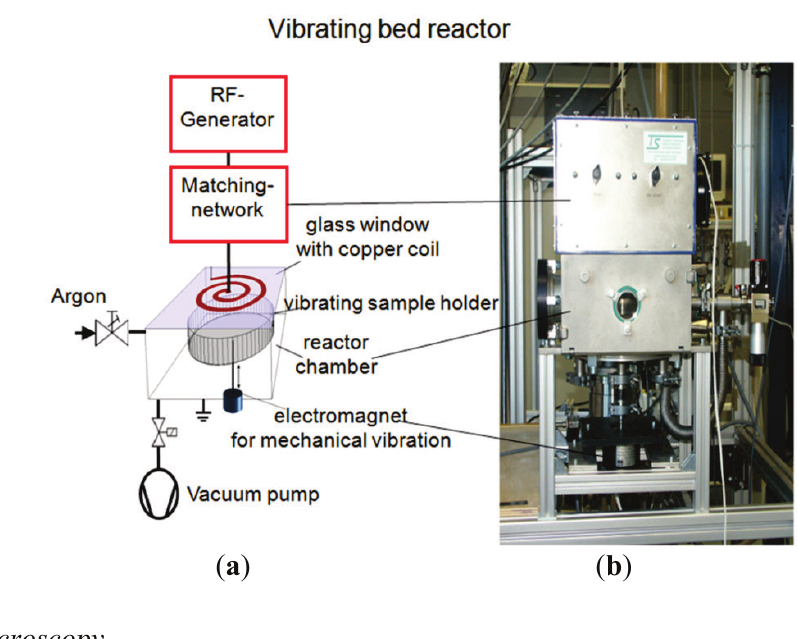
Figure 10. ( a ) Schematic representation and ( b ) Photograph of the experimental set-up for the plasma treatment of the multiwall WS 2